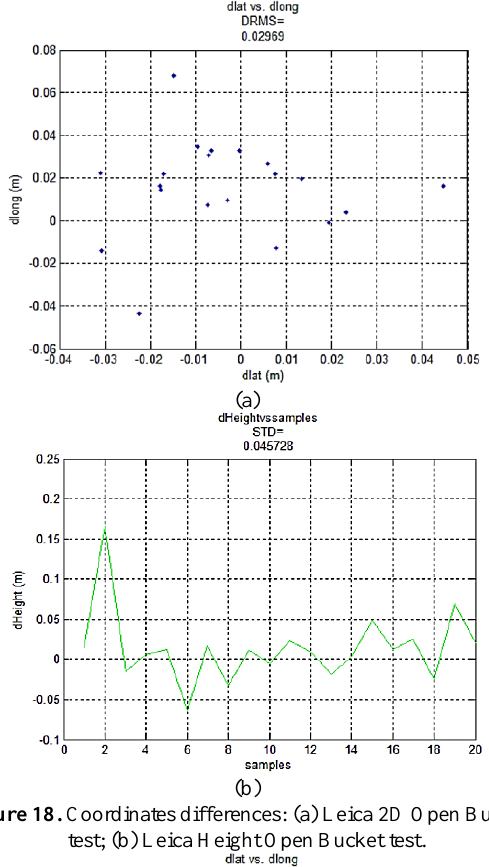
Figure 18. Coordinates differences: (a) Leica 2D Open Bucket test; (b) Leica Height Open Bucket test.